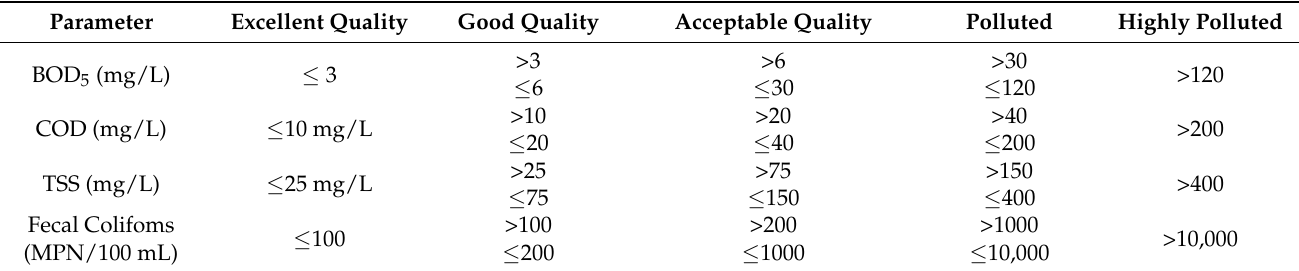
Table 9. Indicator of surface water quality in